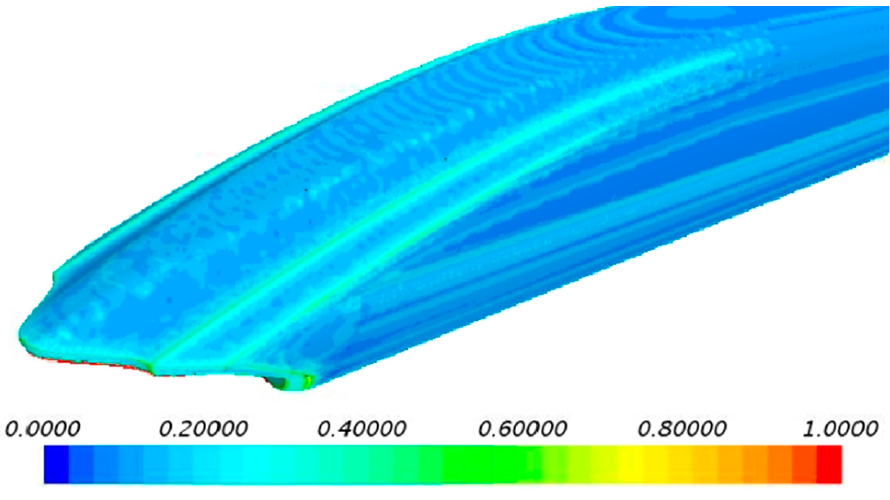
Figure 4. The y + on the train surface.